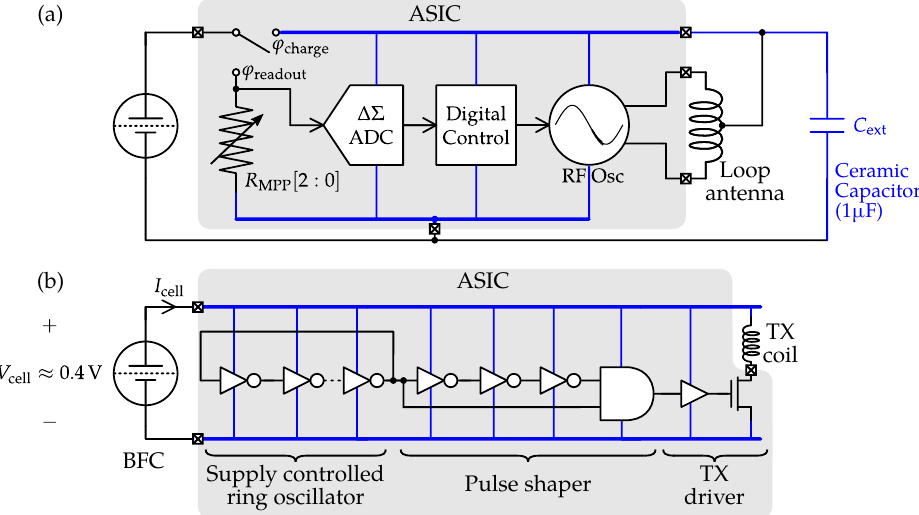
Figure 25. CMOS interface for self-powered fuel cell sensors. (a) two-phase operation approach; (b) free-running oscillator